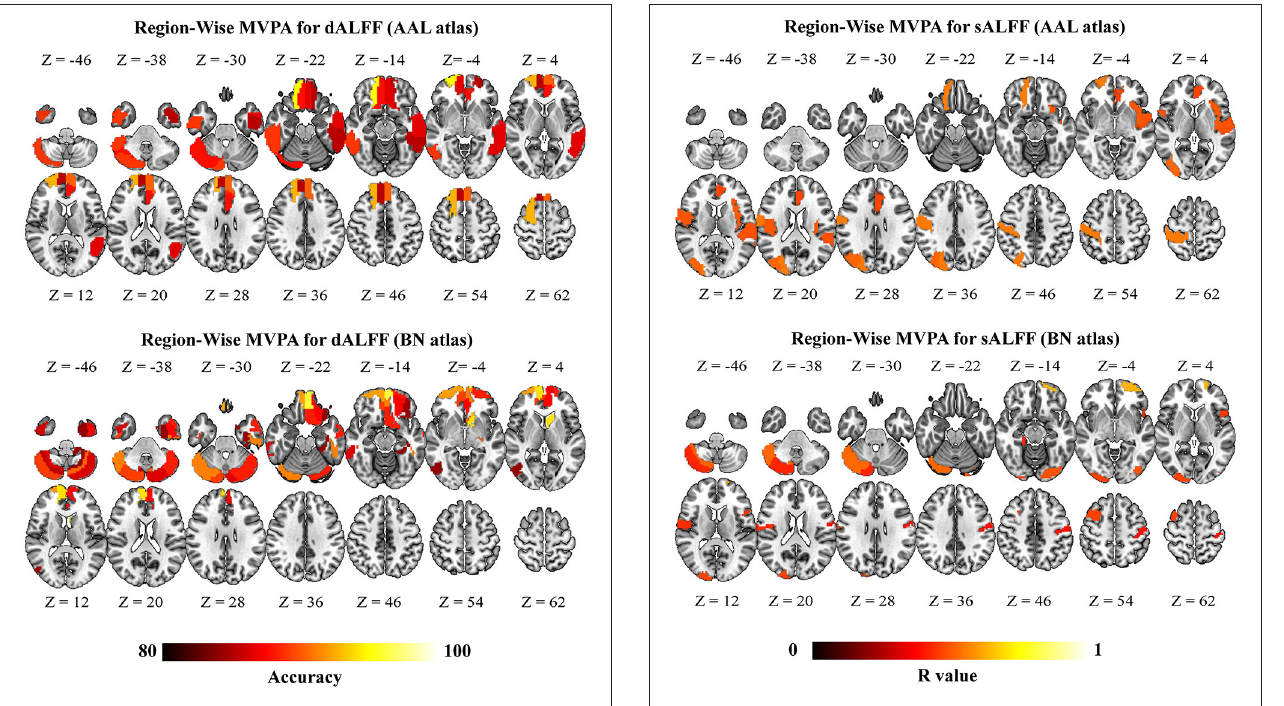
FIGURE 5 | Brain regions with significant classification accuracy for “DCM vs. HC” using the dynamic amplitude of low-frequency fluctuation (dALFF) ( p < 0.05, FWE for multiple comparison correction). DCM, Degenerative Cervical Myelopathy; HC, Healthy Controls; AAL, Anatomical Automatic Labeling; BN, Brainnetome.